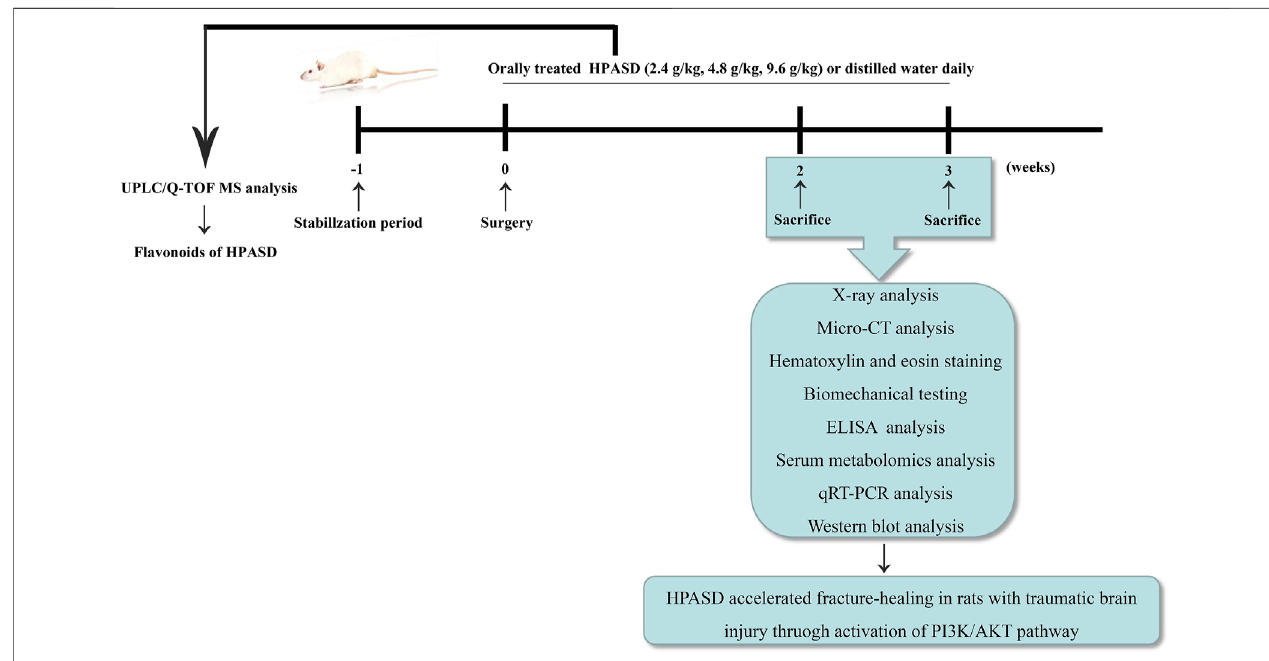
FIGURE 1 | The work fl ow of the pharmacological study of HPASD.